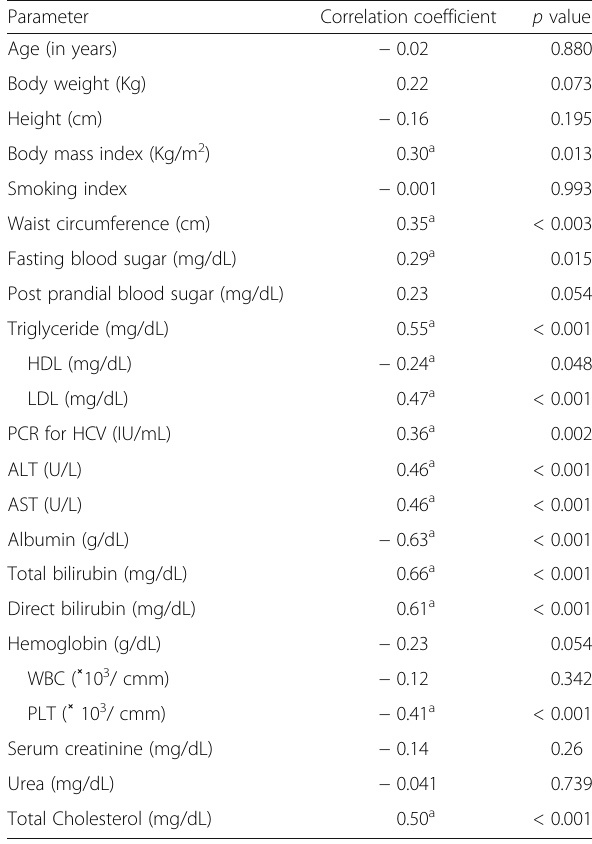
Table 4 Correlation between PTX3 (ng/mL) and all